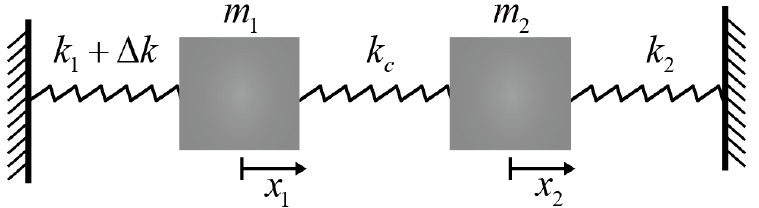
Figure 2. Lumped spring-mass model of the 2-DoF weakly coupled resonators.